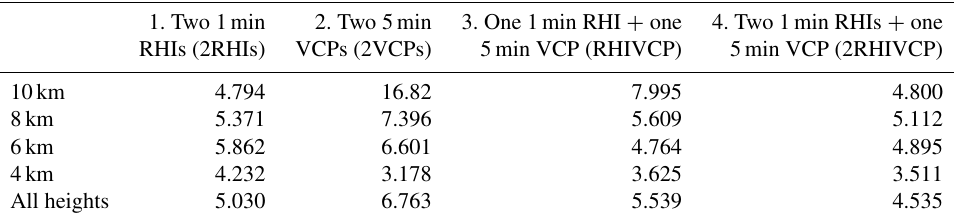
Figure 6. Frequency of maximum updraft magnitudes in detected individual cells as a function of time normalized by the cell duration for the (a) CLN and (b) POL case simulations and (c) the difference between the CLN and POL cases (POL–CLN). Here we present only deep convective cells with 20dBZ echo top heights that exceeded the freezing level during their lifetimes. Color shading in (a) and (b) represents normalized frequency by cell lifetime, and that in (c) represents the difference in the normalized frequency. The sample size at each time bin is presented on the top of (a) and (b) . Black lines in (a) and (b) represent the median value in each time bin. Table 2. The root mean square error (RMSE) of the retrieved updraft averaged over the regions with reflectivity ≥ 40dBZ at four different altitudes as well as all heights for a variety of scan strategies for the entire